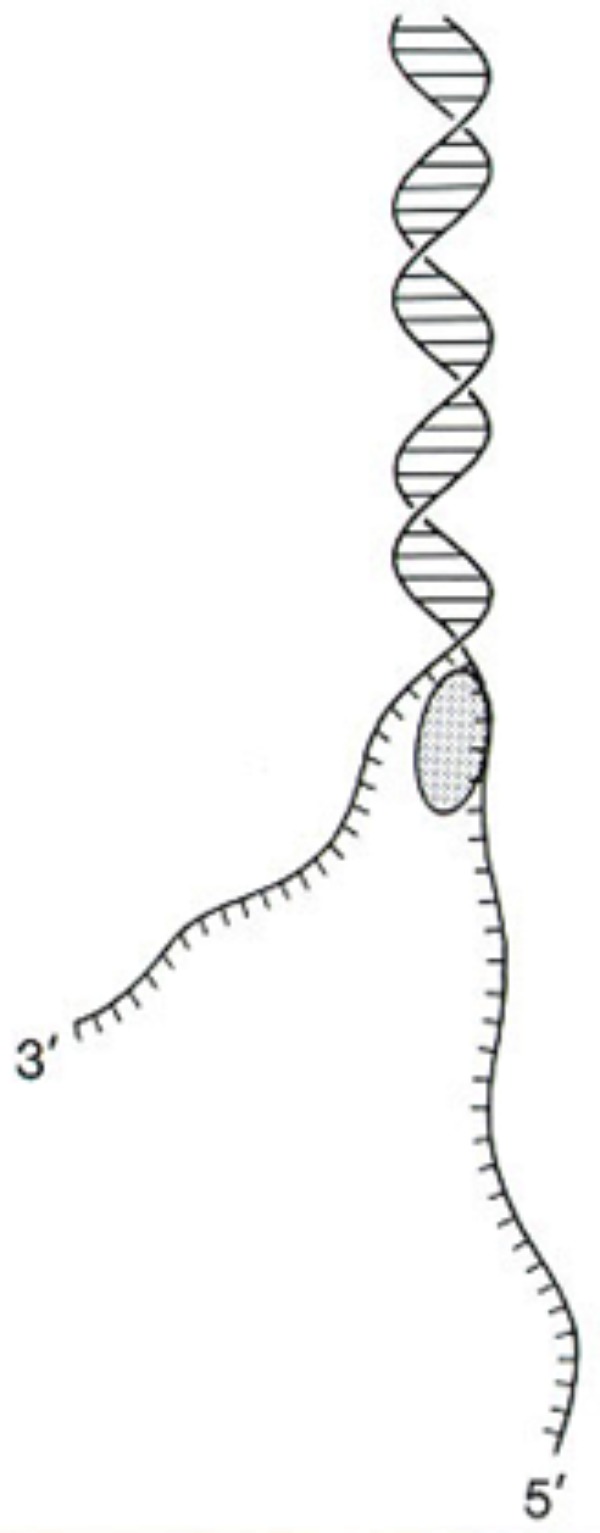
DNA single strands can develop during DNA repair or by DNase I-like or gyrase-like enzymes. Reproduced from a previous publication (Neigeborn and Carlson, 1984).